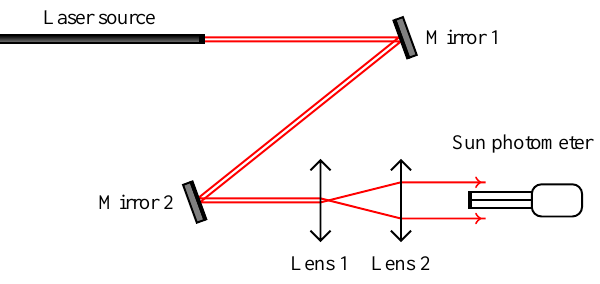
Fig. 13. Optic design to measure the FOV of Sun photometers with a laser beam.